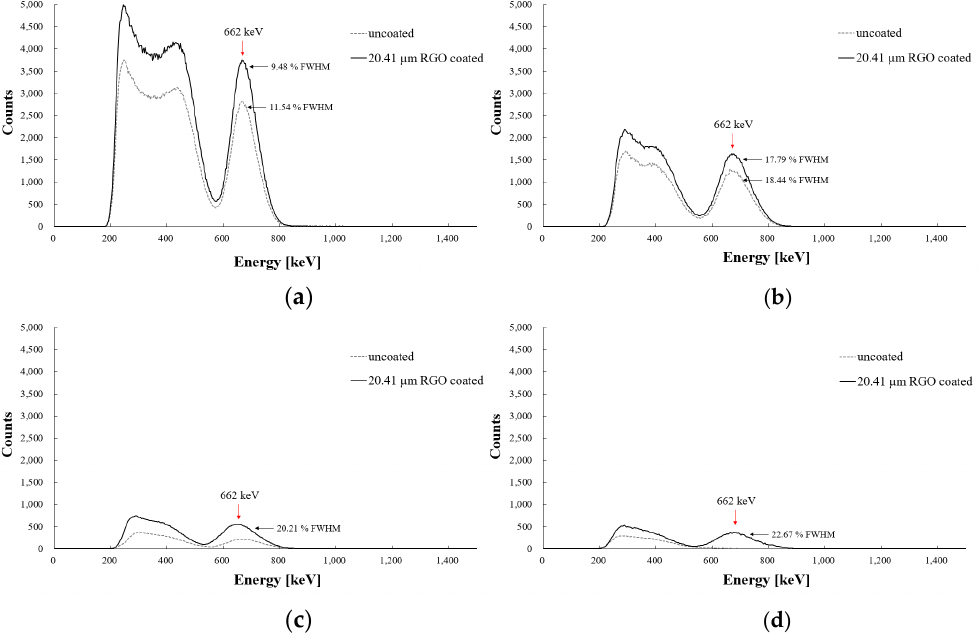
Figure 9. Energy spectra of the 137 Cs radioisotope according to the lengths of a POF in the FORS. ( a ) 1 m, ( b ) 2 m, ( c ) 2.5 m, and ( d ) 3